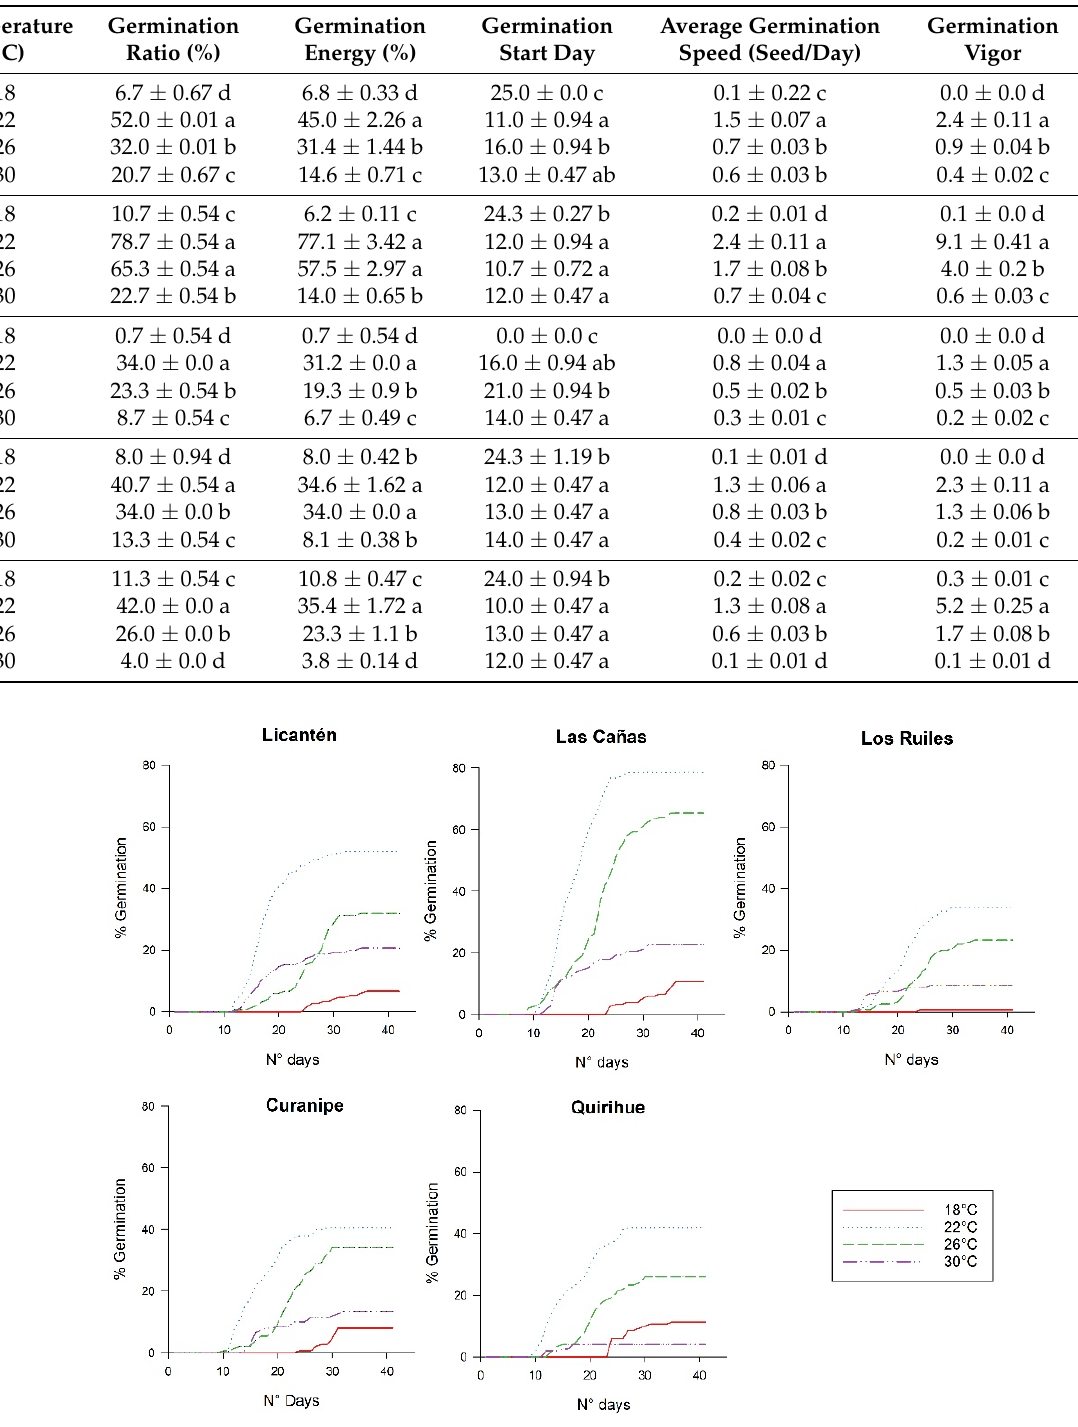
Figure 2. Final germination percentage of five provenances of Nothofagus glauca seeds treated at different temperatures in the absence of light. 3. Discussion Seed germination is a process in which endogenous and exogenous factors intervene. On the one hand, two growth regulators that play a fundamental role in this process are gibberellic acid, a promoter of germination, and abscisic acid (ABA), which is an inhibitor. On the other hand, in addition to humidity and oxygen availability, temperature is the environmental factor with the greatest effect on the germination process of seeds, directly affecting their metabolism and germination speed [8]. With super-optimal temperatures, seed germination is delayed because a high level of ABA is maintained in the embryo and